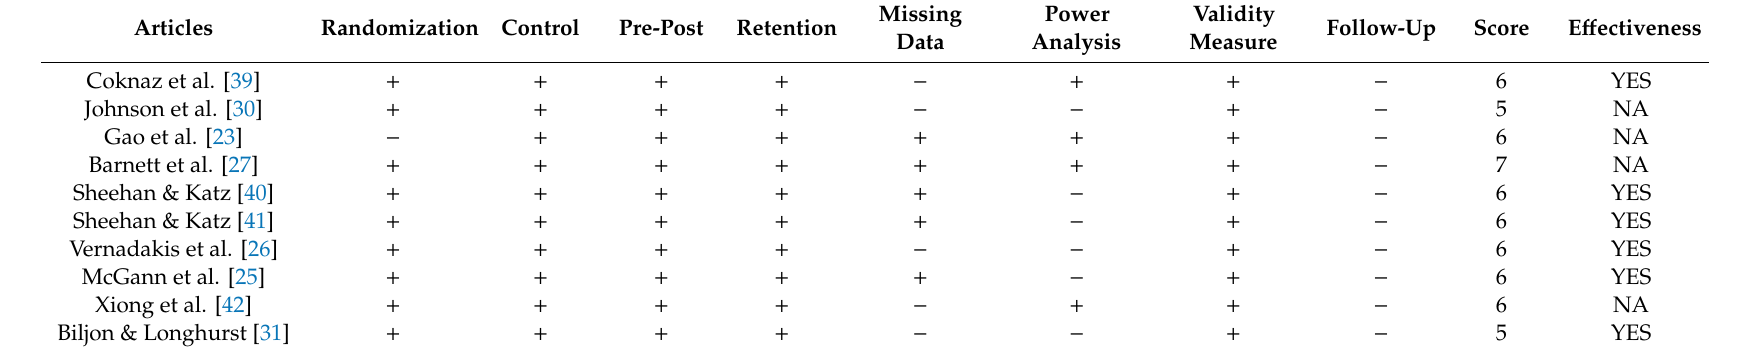
Table 1. Design quality